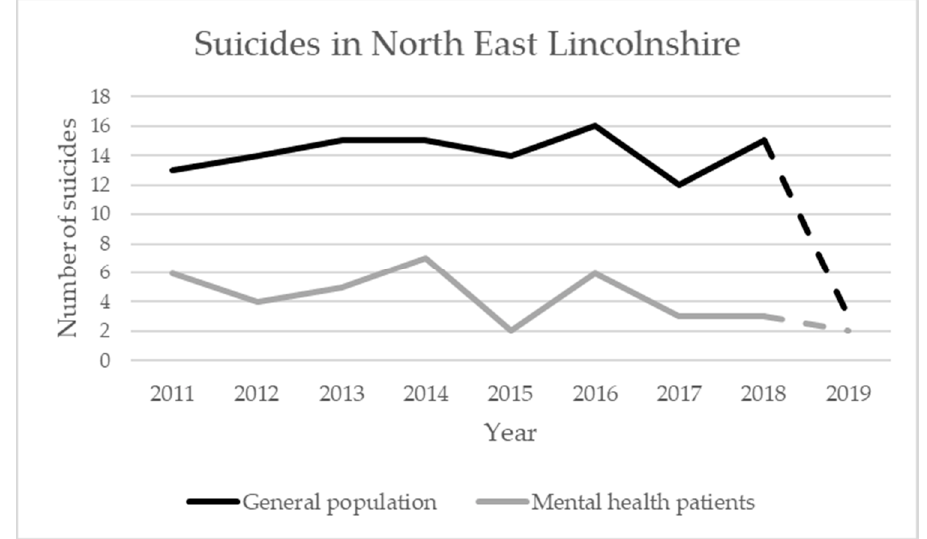
Figure 1. Suicides in North East Lincolnshire 2011–2019 (2018 / 19 data subject to ratification). The continuous line represents confirmed deaths by suicide, whereas dashed lines for years 2018 / 19 are tentative until legally confirmed via judgement at Coroner’s Court where conclusions of death by suicide are formally established in the United Kingdom.